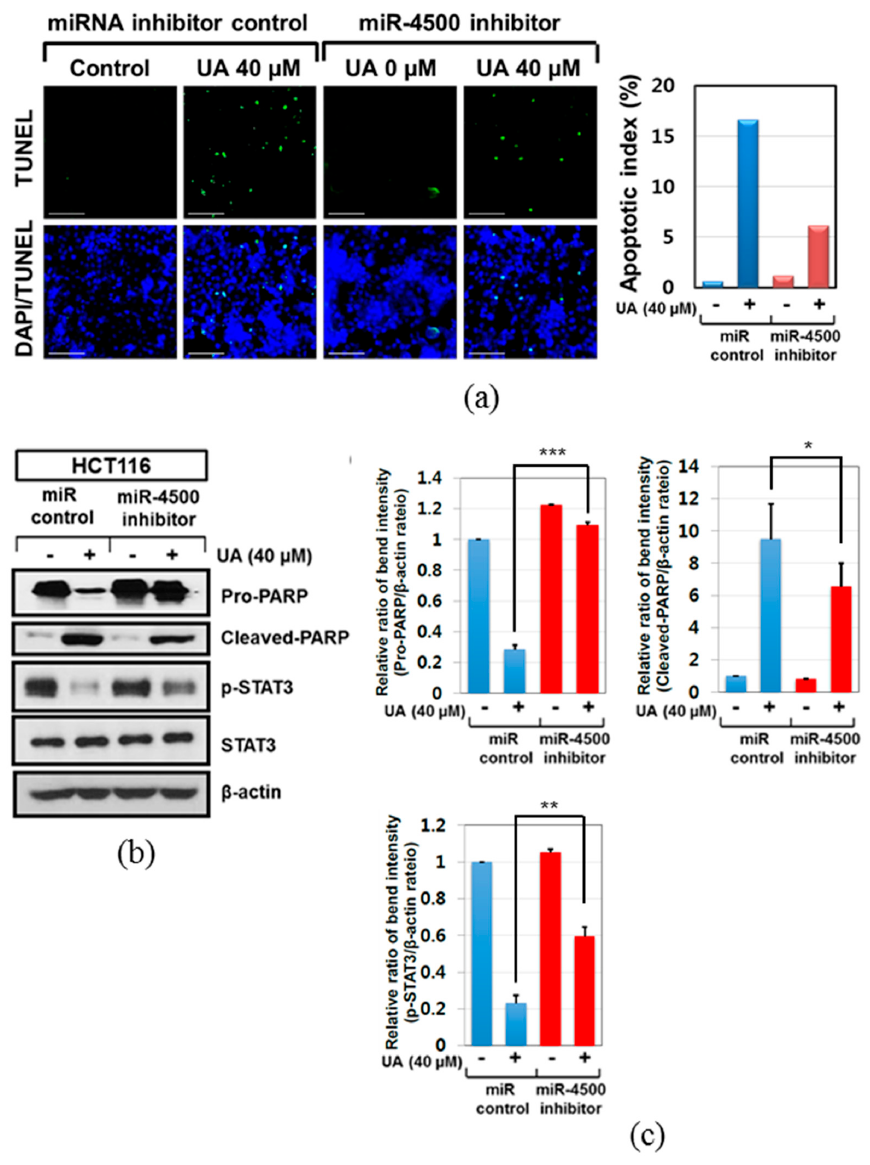
Figure 5. Critical role of miR-4500 in apoptotic effect of ursolic acid in HCT116 cells. ( a ) Effect of miR-4500 inhibitor on the number of TUNEL positive cells in ursolic acid treated HCT116 cells by TUNEL assay. Scale bar = 40 µ m. Bar graphs showed quantification of TUNEL-positive cells (%). ( b ) Effect of miR-4500 inhibitor on PARP, p-STAT3, and STAT3 in ursolic acid treated HCT116 cells. ( c ) Bar graphs represent the relative expression of PARP or p-STAT3 to β -actin by using Image J software (https://imagej.nih.gov/ij/download.html). * p < 0.05, ** p < 0.01, *** p < 0.001 vs. miRNA-4500 inhibitor negative control.